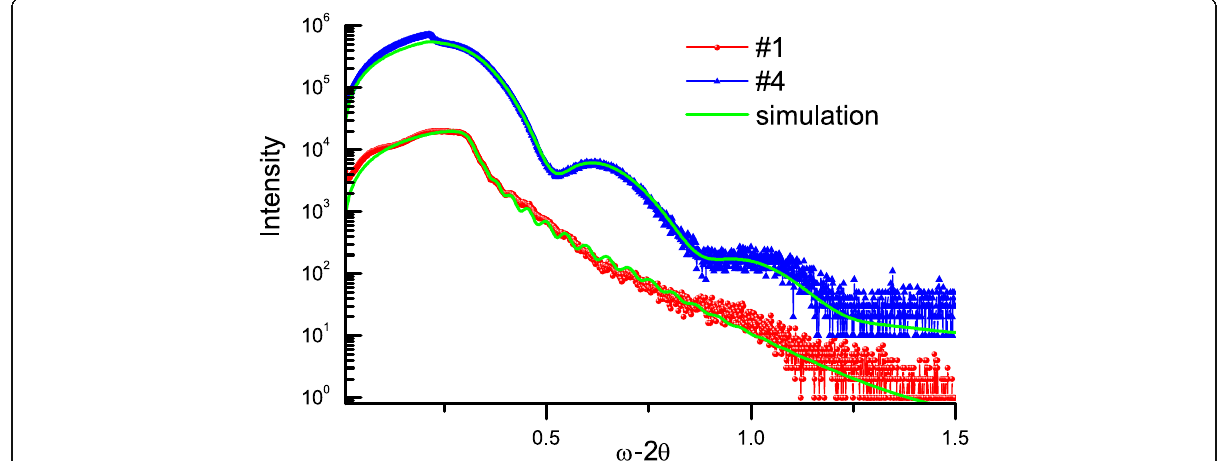
Fig. 2 X-ray reflectivity curves of Fe 2 O 3 − X (sample #1) film and Fe 2 O 3 − Y /Cr 3 − X O 3 − Y multilayer (sample #4) deposited on Si substrate. Green lines show